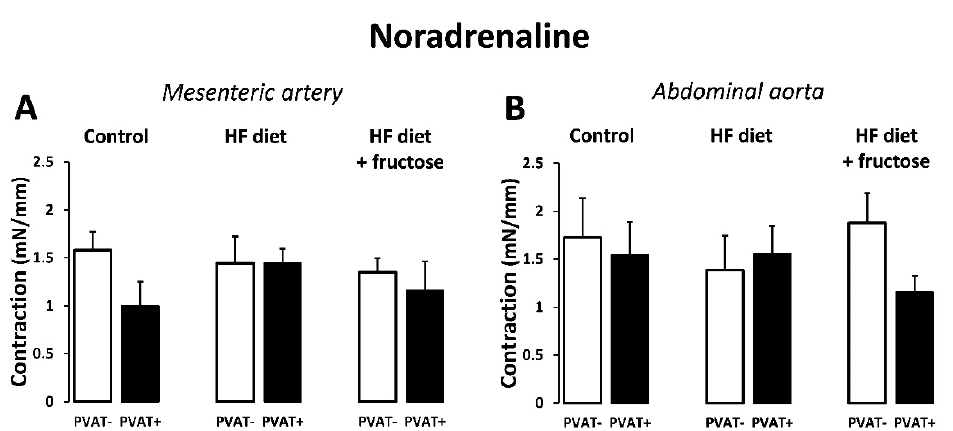
Figure 6. Contractile responses to exogenous noradrenaline (1 µ M): comparison of PVAT(+) and PVAT( − ) preparations of mesenteric artery ( A ) and abdominal aorta ( B ) in Wistar–Kyoto rats: control, treated with high-fat (HF) diet, and treated with HF diet + fructose. Values represent means ± SEM; n = 6.